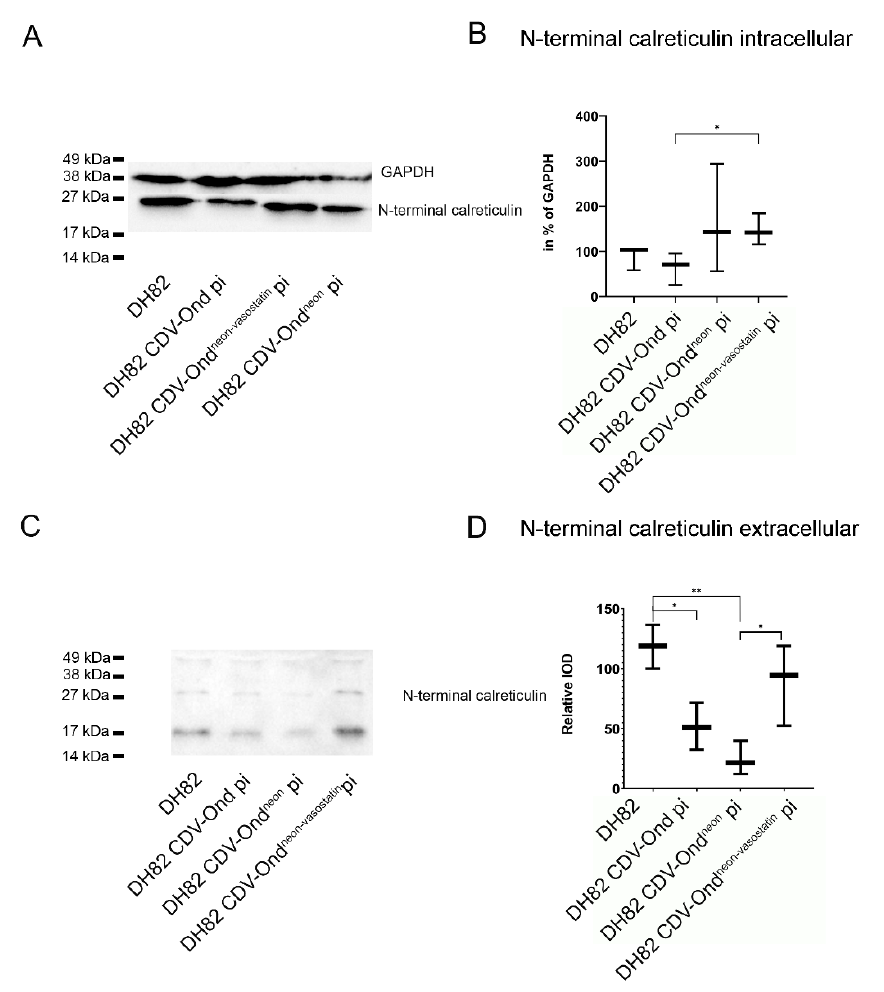
Figure 8. Western blot analysis of intracellular ( A , B ) and extracellular ( C , D ) proteins using an N-terminal calreticulin antibody. ( A ) Immunoblotting with an N-terminal calreticulin antibody of intracellular proteins showed significant differences in sizes and intensities of bands at 27 kDa between DH82 cells persistently infected with CDV-Ond neon-vasostatin and DH82 cells persistently infected with CDV-Ond. ( B ) Intracellular amount of N-terminal calreticulin in % of GAPDH. Box plots represent minimum, median and maximum. Significant differences (Mann–Whitney U test) are labeled by asterisks: * = p ≤ 0.05. ( C ) The supernatant of DH82 cells persistently infected with CDV-Ond neon-vasostatin contained significantly more 27 kDa N-terminal calreticulin compared to DH82 cells persistently infected with CDV-Ond neon . In addition, the supernatant of DH82 cells contained significantly more 27 kDa N-terminal calreticulin compared to DH82 cells persistently infected with CDV-Ond and CDV-Ond neon . ( D ) Densitometric analysis of the amount of vasostatin within the culture supernatant. Box plots represent minimum, median and maximum. Significant differences (Mann–Whitney U test) are labeled by asterisks: * = p ≤ 0.05; ** = p < 0.01. IOD—integrated optical density.